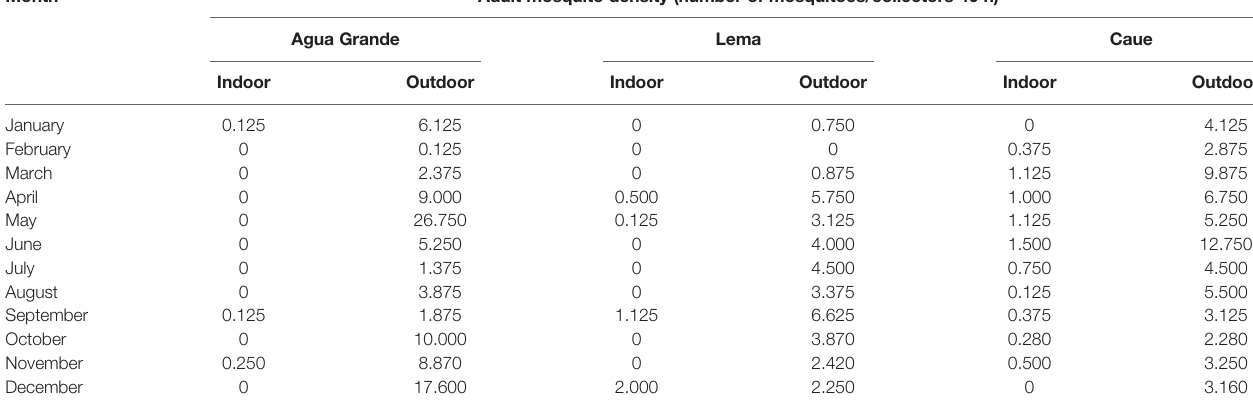
TABLE 2 | Adult mosquito density survey in the study sites in